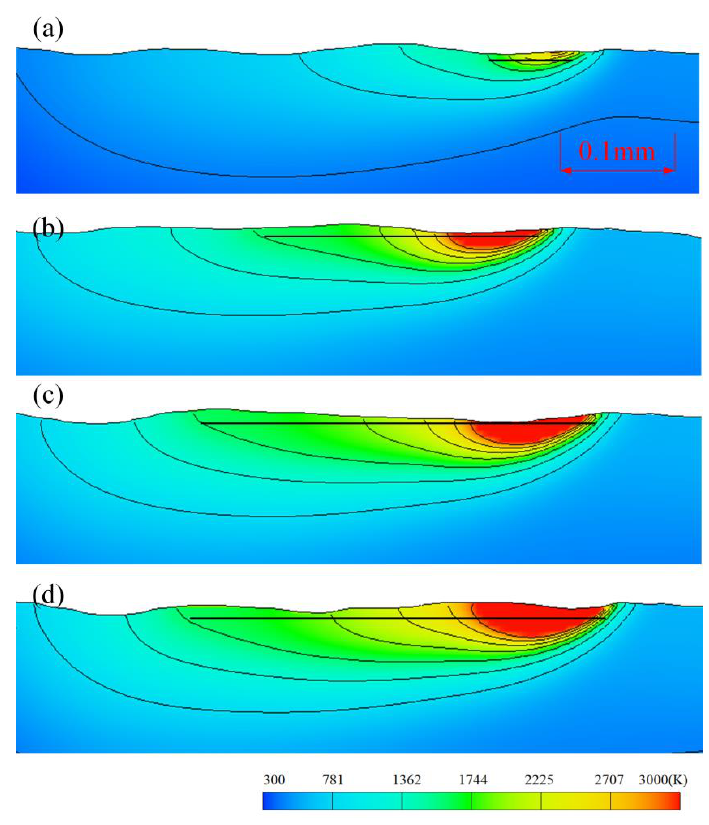
Figure 9. The temperature contours of ILP with different ILP power. ( a ) 50 W; ( b ) 90 W; ( c ) 130 W; ( d ) 170 W. The scanning speed was 0.8 m/s, and the spot diameter was 0.05 mm. The entire domain is 0.6 mm long and 0.13 mm high.